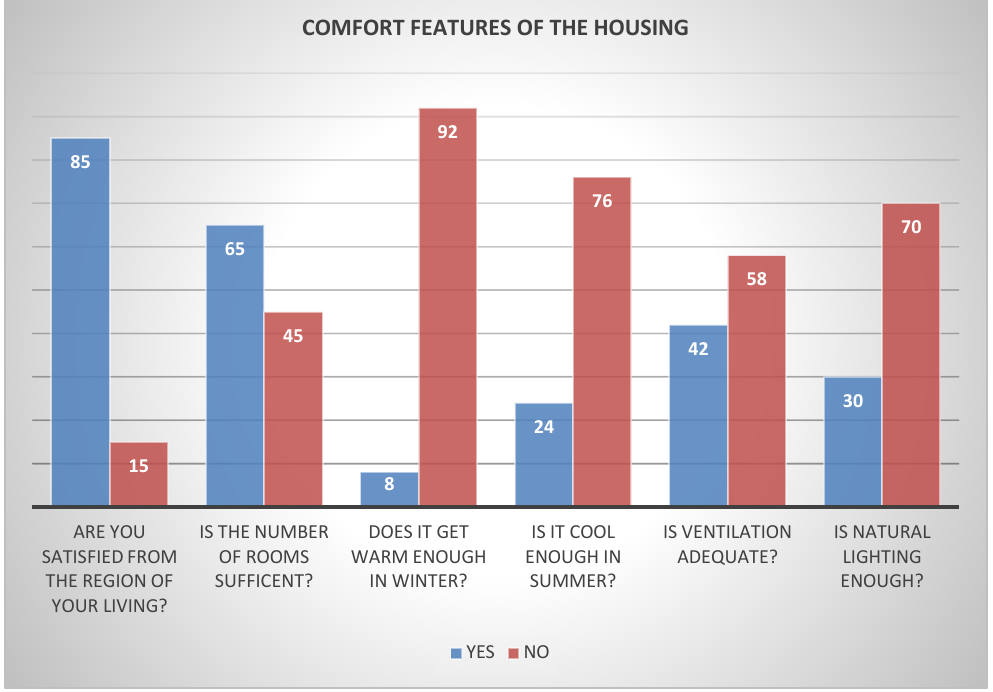
Figure 3. Comfort properties of the refugees' residences